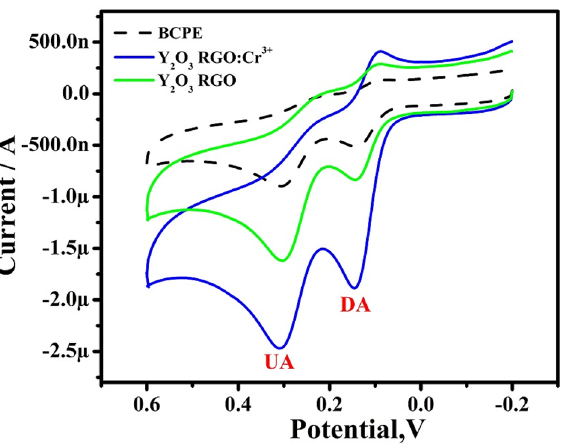
Figure 9. CVs for selectivity analysis for 10 µM DA & 10 µM UA at BCPE & MCPE at a scan rate of 50 mVs -1 .